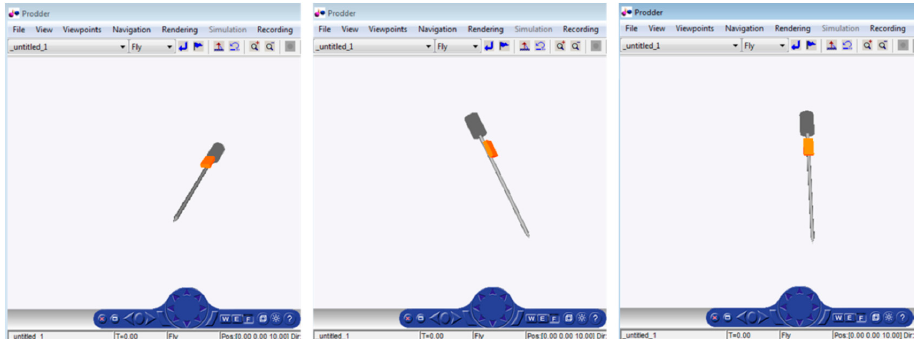
Figure 5. Different snapshots from the prodder monitoring.